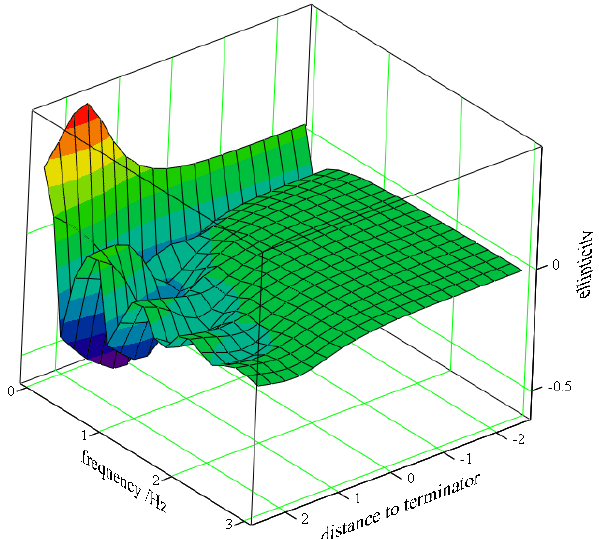
Fig. 5. The ellipticity (cid:15) as a function of distance (normalized by the terminator characteristic scale L ) relative to the terminator’s zero- line, as well as a function of frequency for a plasma density propor- tional to N e = N 0 · ( 2 / 3 ) − ( 1 / 3 ) tanh (x/L) and an effective iono- ·√ 3 + 2tanh ( + x/L − 0 . 4 ) . spheric thickness that changes as l H = l H 0 Time runs from left to right ( L = − 2, − 1, 0, 1, 2). For details see